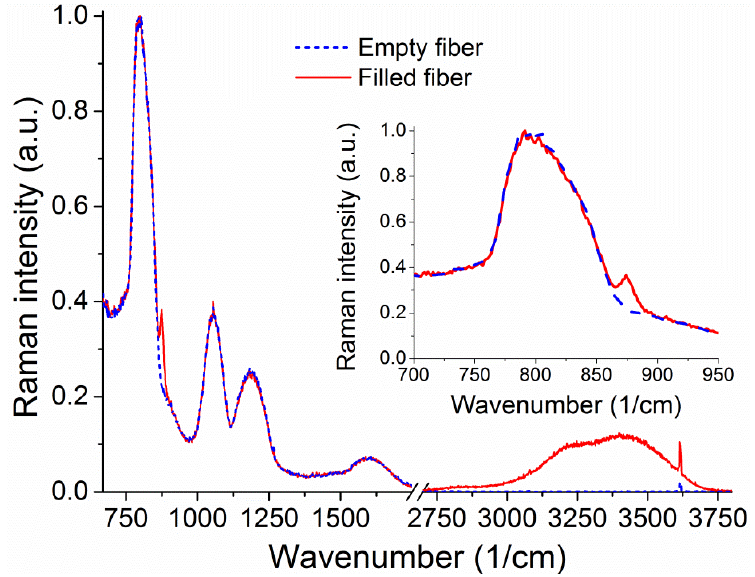
Figure 6. Raman signal collected from an empty silica suspended core fiber (blue, dashed line) and the same fiber filled with a hydrogen peroxide aqueous solution (red, solid line) for 488 nm CW excitation. The region from 2,000 to 2,600 cm −1 is not shown as it contains no useful information. The inset shows the region of interest for hydrogen peroxide, between 700 and 950 cm −1 for